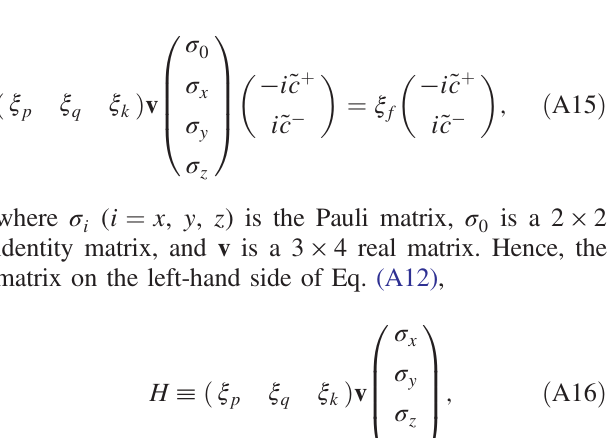
FIG. 6. The dispersion near the Weyl points. Panels (a) – (c) show the comparison between the numerical result (blue circles) and the effective Hamiltonian in Eq. (A16) (red dashed lines) in three directions. The parameters of the PC are given by d a ¼ 97 nm, d 72 nm, and the Weyl point considered is between the first and the second b ¼